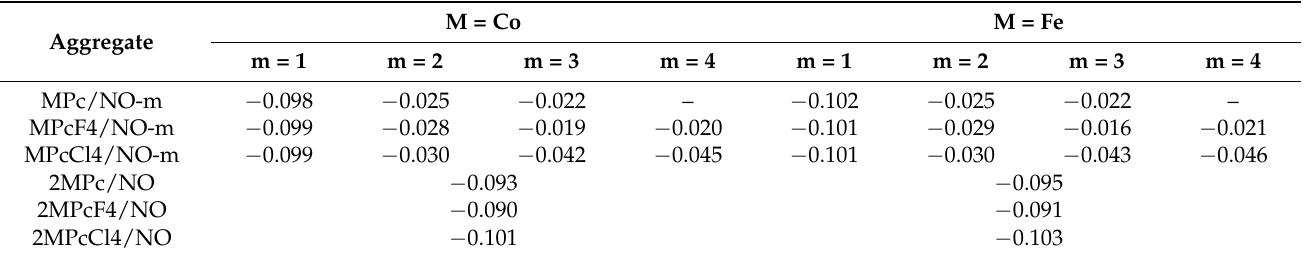
Table 3. The NO molecule E b values (eV) in MPcR 4 /NO- m and 2MPcR 4 /NO